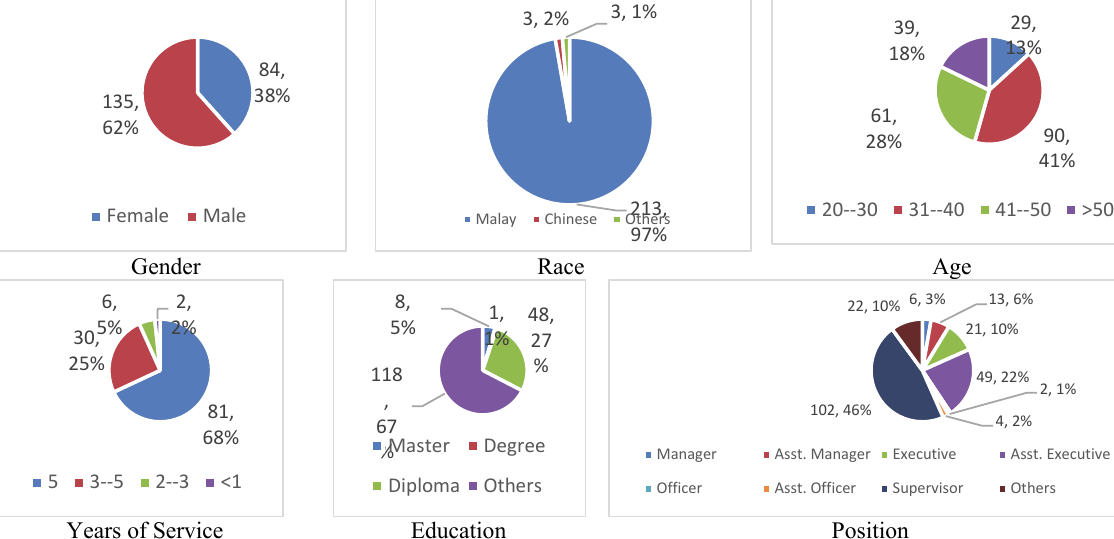
Fig. 2. Demographic data of the